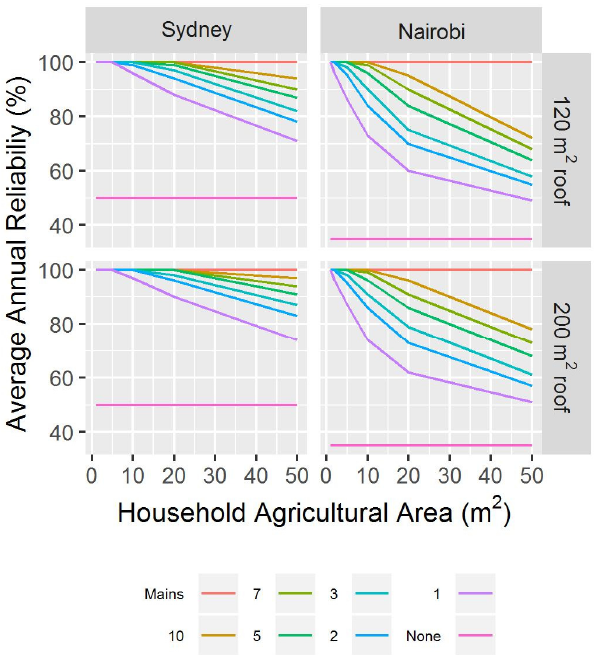
Figure 1. Average annual RSS reliability for various HA areas (1, 2, ..., 10 indicate size of RSS in m 3